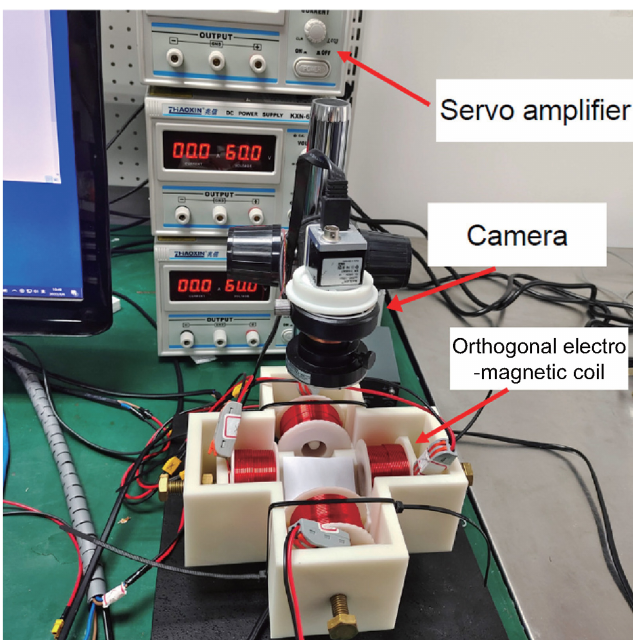
Figure 4. Experimental setup of a magnetic actuation system consisting of a three-axis orthogonal electromagnetic coil device, a Petri dishes (35 mm in diameter) with the robot inside, a top camera, and a side movable